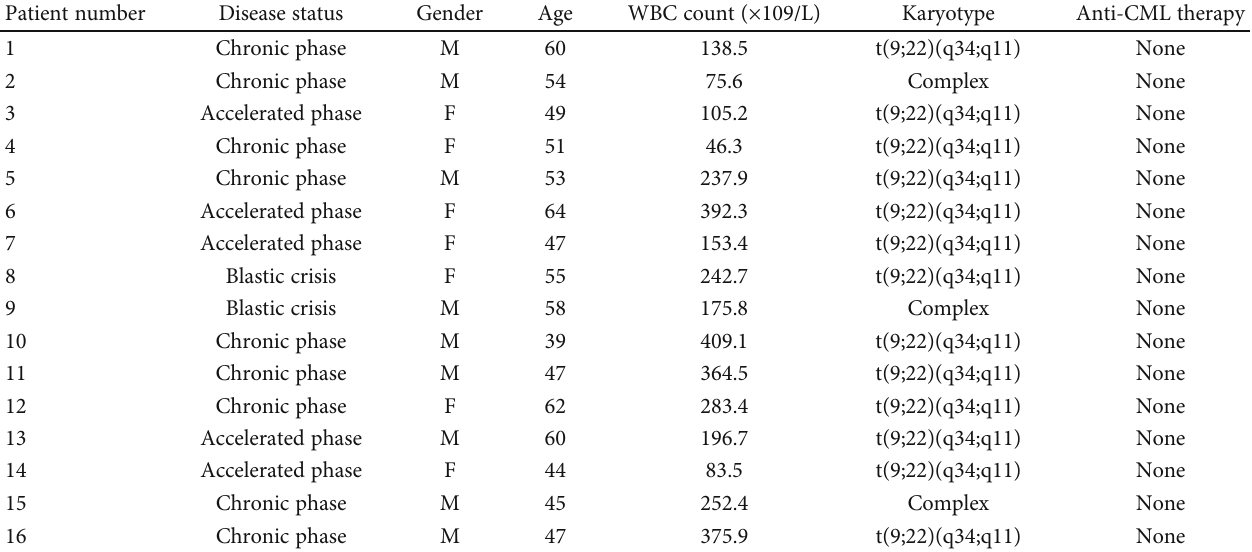
Table 1: The characteristics of the 16 patients with